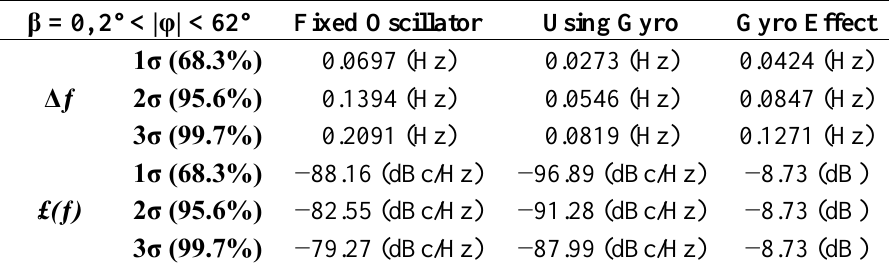
Figure 24. Average instability caused by random vibration. ( a ) Frequency jitter; ( b ) Phase noise. Table 9. Average efficiency of gyroscopic mounting for random